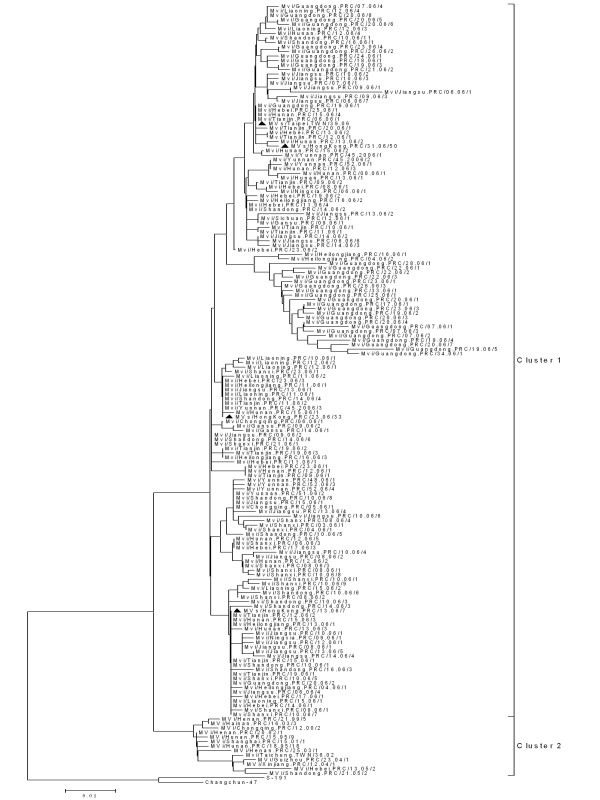
Phylogenetic tree of measles wild-type virus strains of China in 2006 and H1 reference MeV strains based on the 450 nucleotide sequences coding for the COOH-terminus of the nucleoprotein. The black triangles indicate MeV isolates Taiwan or Hong Kong China.